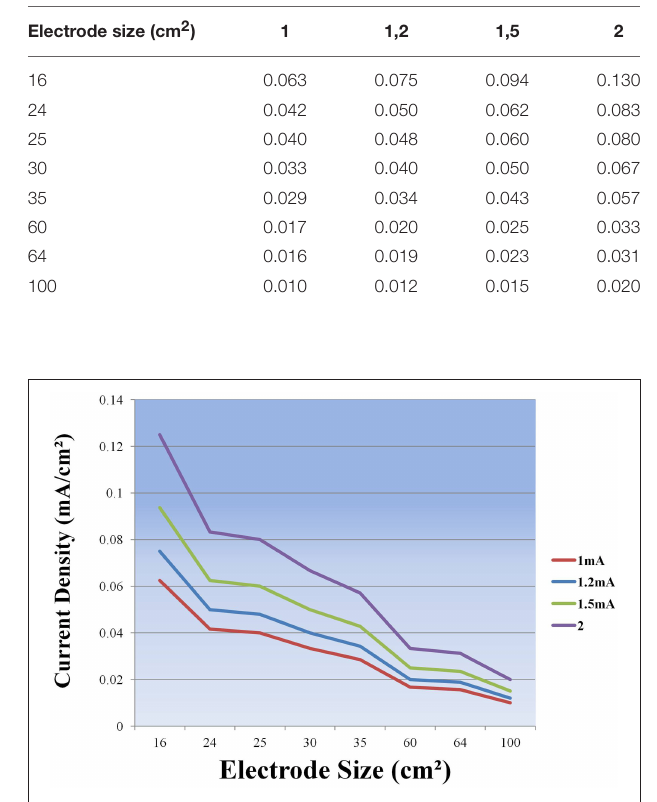
FIGURE 3 | Current Density (mA/cm 2 ) as a function of electrode